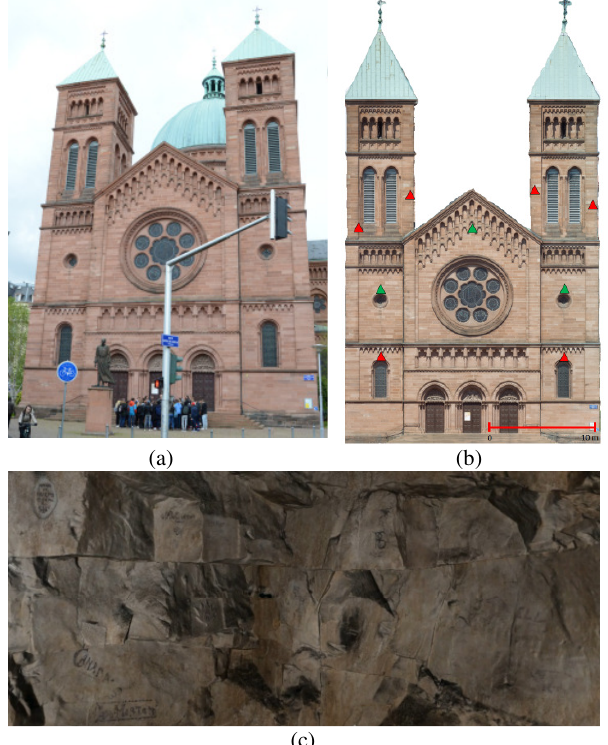
Figure 1. (a) One image of the main façade in the St-Pierre data set. (b) An orthophoto of the façade. Red triangles denote GCPs. Green triangles denote CPs. (c) The site for the Lacey data